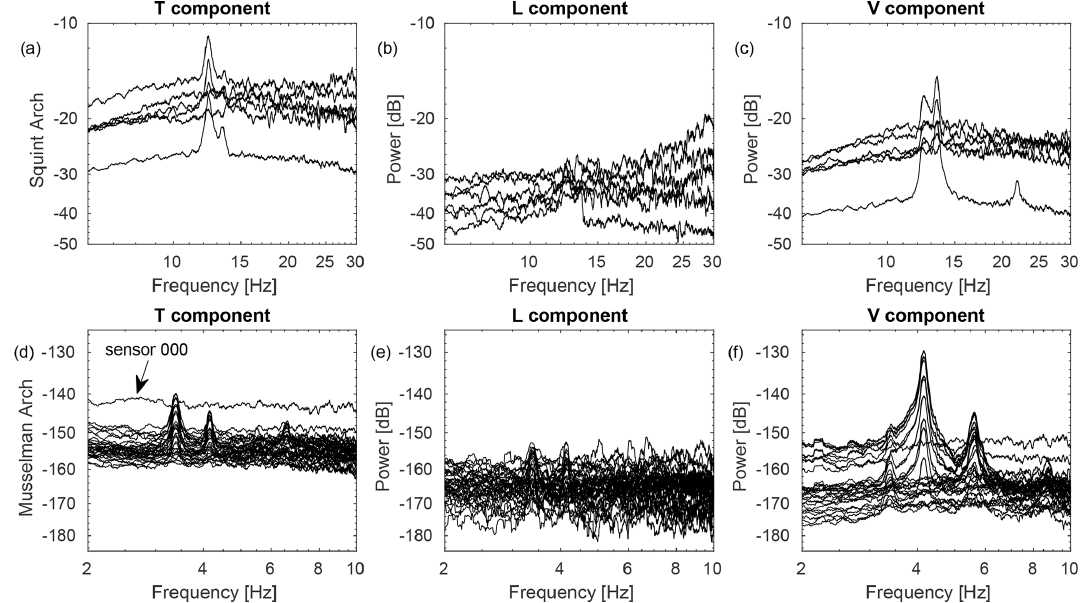
Figure A1. (a–c) Power spectra of the geophone array deployed at Squint Arch, consisting of six sensors and three spatial recording components. Components are oriented transverse to the arch span (T), longitudinal or parallel to the arch (L), and vertical (V). (d–f) Power spectra of the geophone array deployed at Musselman Arch, consisting of 32 sensors and three spatial recording components (T, L,